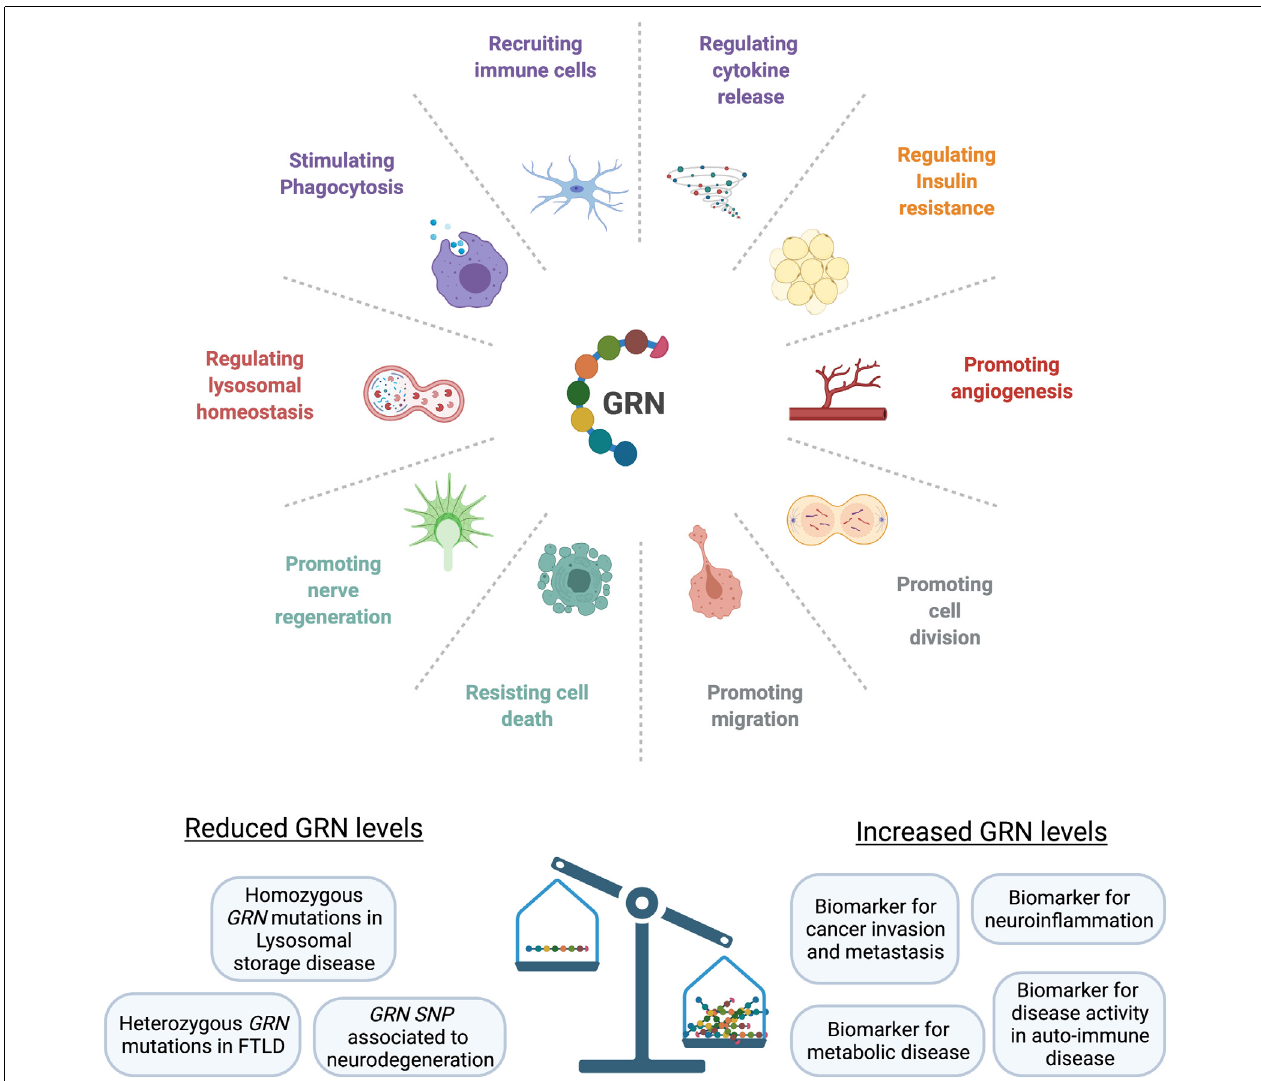
FIGURE 1 | GRN affects multiple biological functions. At physiological levels, GRN is involved in development, fine-tuning the immune response, orchestrating tissue repair, and providing neurotrophic support. Loss of progranulin can lead to an uncontrolled inflammatory response, loss of lysosomal homeostasis, and neuronal death. GRN levels are elevated in cancer, metabolic diseases, and chronic inflammatory states (SNP, single-nucleotide polymorphism; FTLD, Frontotemporal lobar